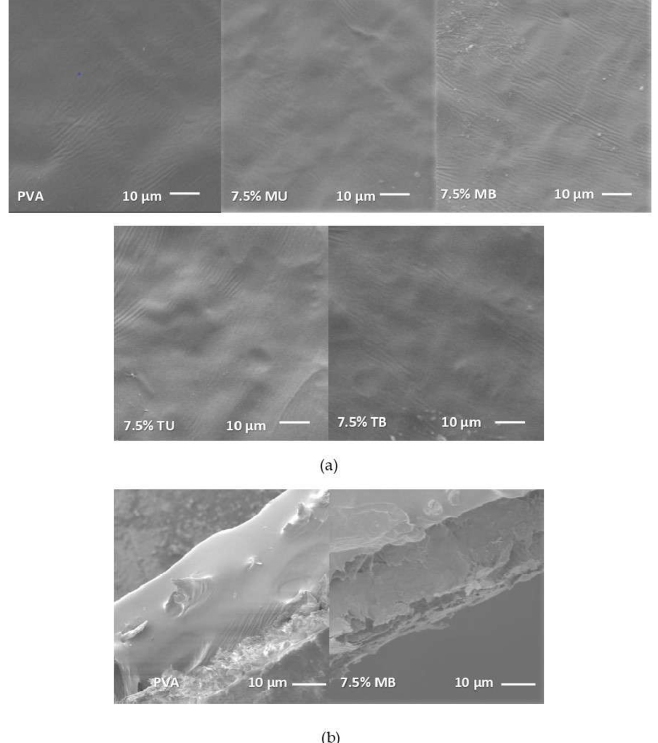
Figure 2. SEM micrographs of pure PVA and PVA-(L)CNF fi lms. ( a ) the surface of pure PVA, PVA containing 7.5% of mechanical unbleached nanocellulose (7.5% MU), PVA containing 7.5% of me- chanical bleached nanocellulose (7.5% MB), PVA containing 7.5% of TEMPO unbleached nanocel- lulose (7.5% TU), PVA containing 7.5% of TEMPO bleached nanocellulose (7.5% TB); ( b ) cross sec- tion of pure PVA and PVA containing 7.5% of mechanical bleached nanocellulose (7.5% MB). Taken from Sánchez et al. [24].